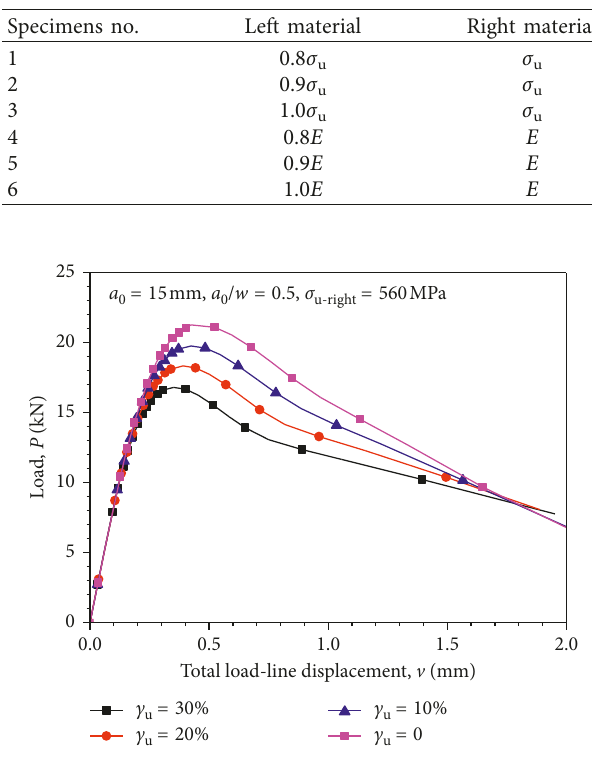
Figure 5: Load-applied displacement curve of ultimate tensile strength mismatch specimen.